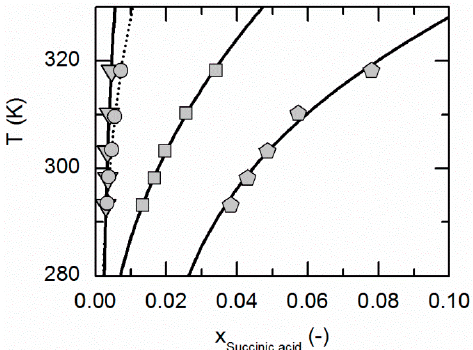
Figure 2. Solubility of succinic acid in ethyl acetate (circles, dotted line), acetonitrile [26] (triangles), ethanol [26] (pentagons) and water [26] (squares). Lines correspond to the PC-SAFT correlations; symbols represent the experimental data points.